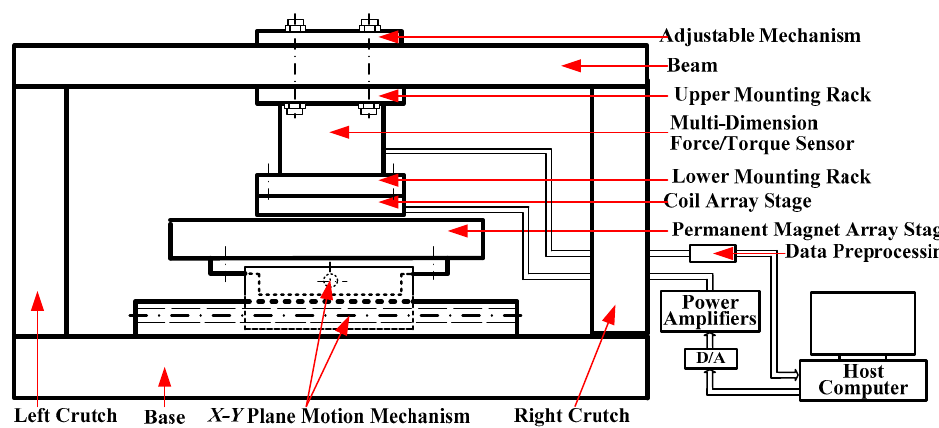
Figure 12. Configuration of comprehensive measurement platform (system)